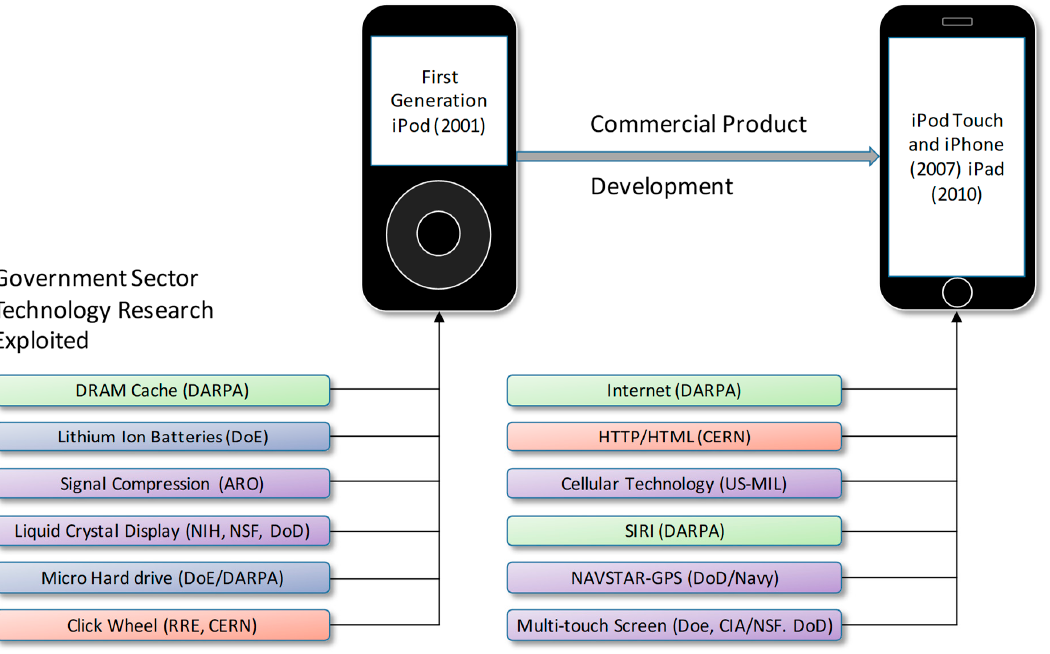
Figure 2. Mobile phone origins (derived from Mazzucato (2015) [8]).